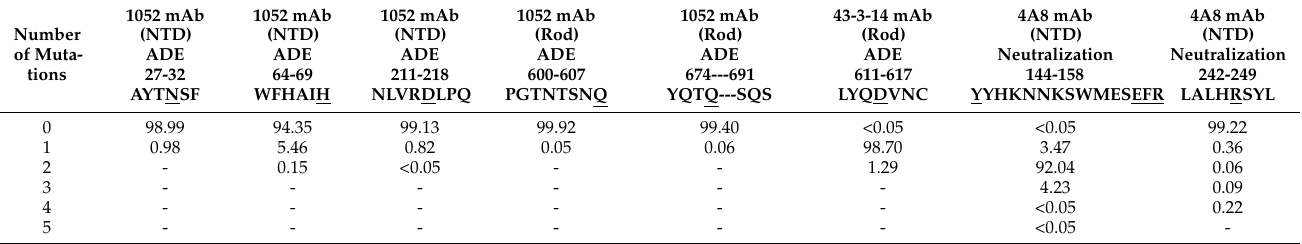
Table 2. Frequency of ADE and neutralizing epitope